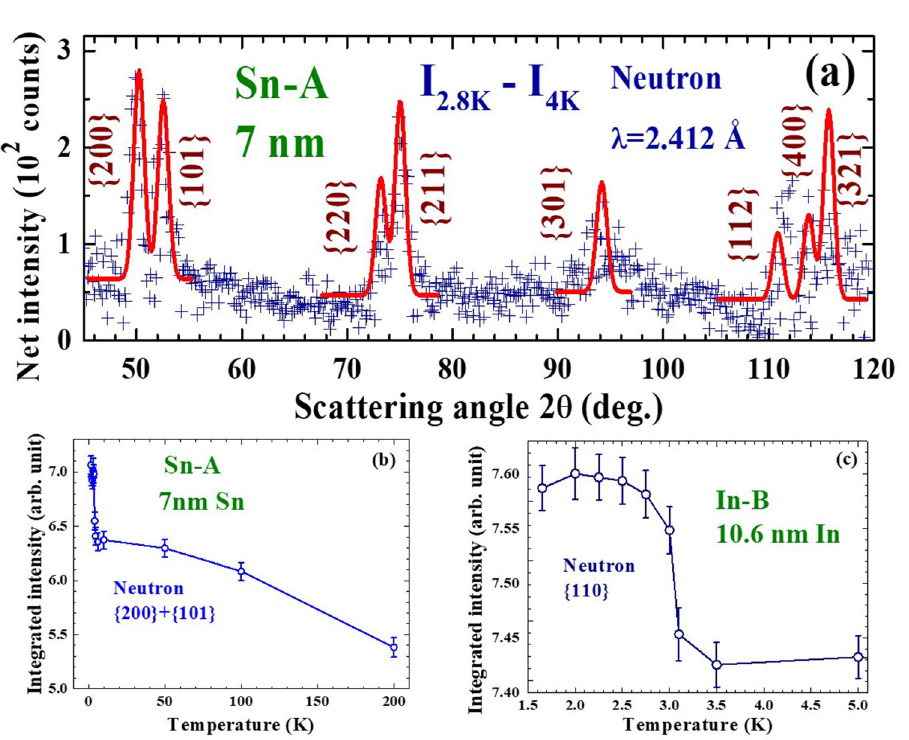
Figure 3. ( a ) Difference pattern of the 7 nm Sn nanoparticles between the neutron diffraction patterns taken at 2.8 and 4 K, revealing significant enhancement of the reflection intensities in the superconducting state. ( b ) Temperature dependence of the (200) + (101) reflection of the 7 nm Sn nanoparticles, revealing a ~ 19% increase in the intensity upon cooling from 200 to 4 K and an additional 10% increase upon further cooling to 1.65 K. ( c ) Temperature dependence of the (110) reflection of the 10.6 nm In nanoparticles, revealing a progressive increase in the intensity upon cooling to the superconducting